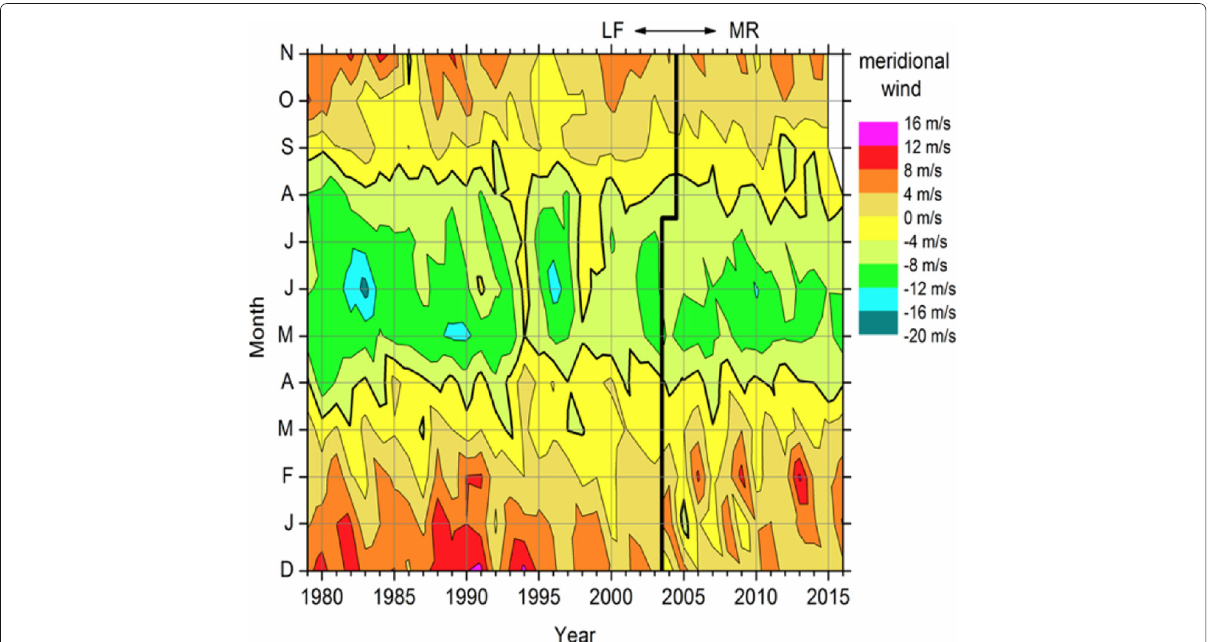
Fig. 11 Long-term trend in meridional wind Meridional wind near 90 km, Collm, Central Europe, 1979–2016. Reproduced from Lastovicka, J., Beig, G., DeLand, M., Jacobi, C., Keckhut, P., Mlynczak, M., Qian, L. (2017), ProgressreachedbyROSMICWG3"TrendsinMesosphereandLowerThermosphere" . VarSITI Newsletter, 15,